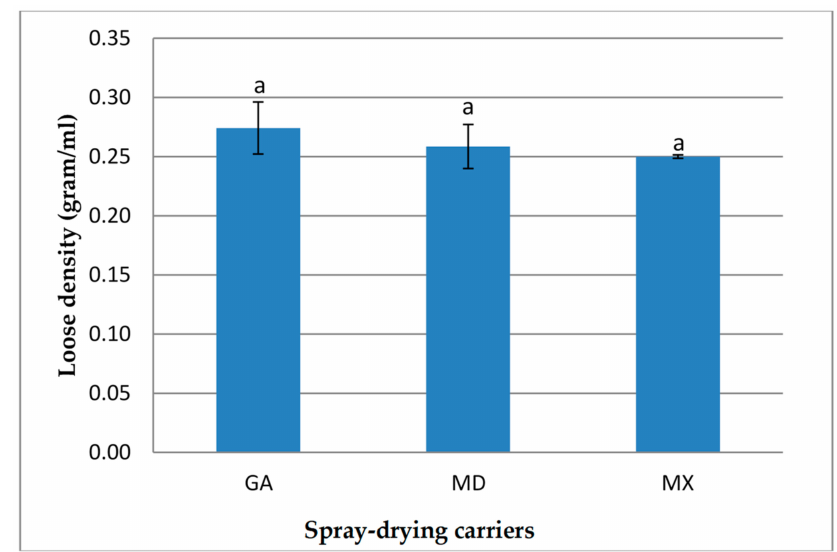
Figure 7. Loose density (g/mL) of lemongrass leaf extract powders using different spray-drying carriers. All data are the mean ± SD. Values with different letters are significantly different ( p < 0.05).